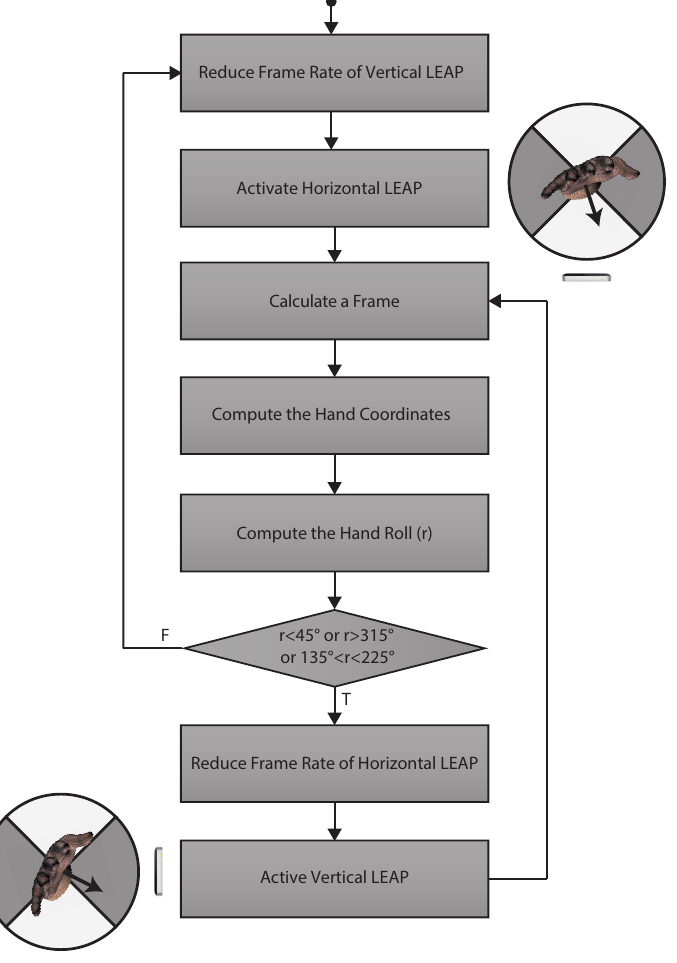
Figure 3. Flow chart of the tracking procedure: the hand was tracked by both sensors, the roll r with respect to the horizontal reference system was computed and used to determine the active sensor. The corresponding active sensor was graphically illustrated on the flow chart sides. The hand coordinates were always referred to the horizontal LEAP reference